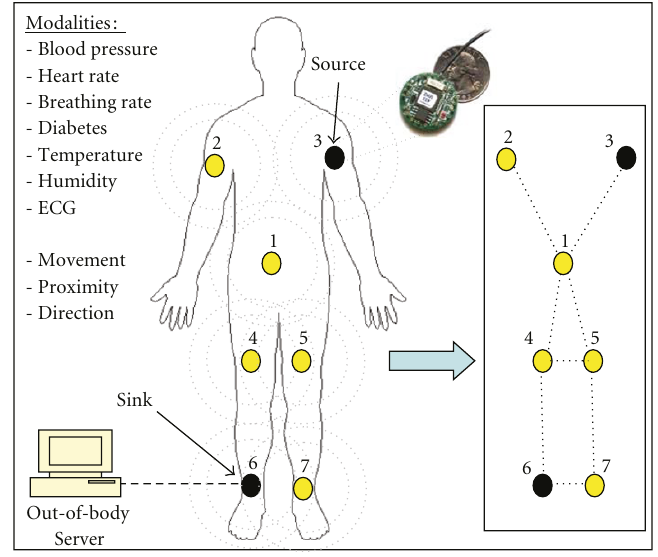
Figure 1: Body area sensor network.